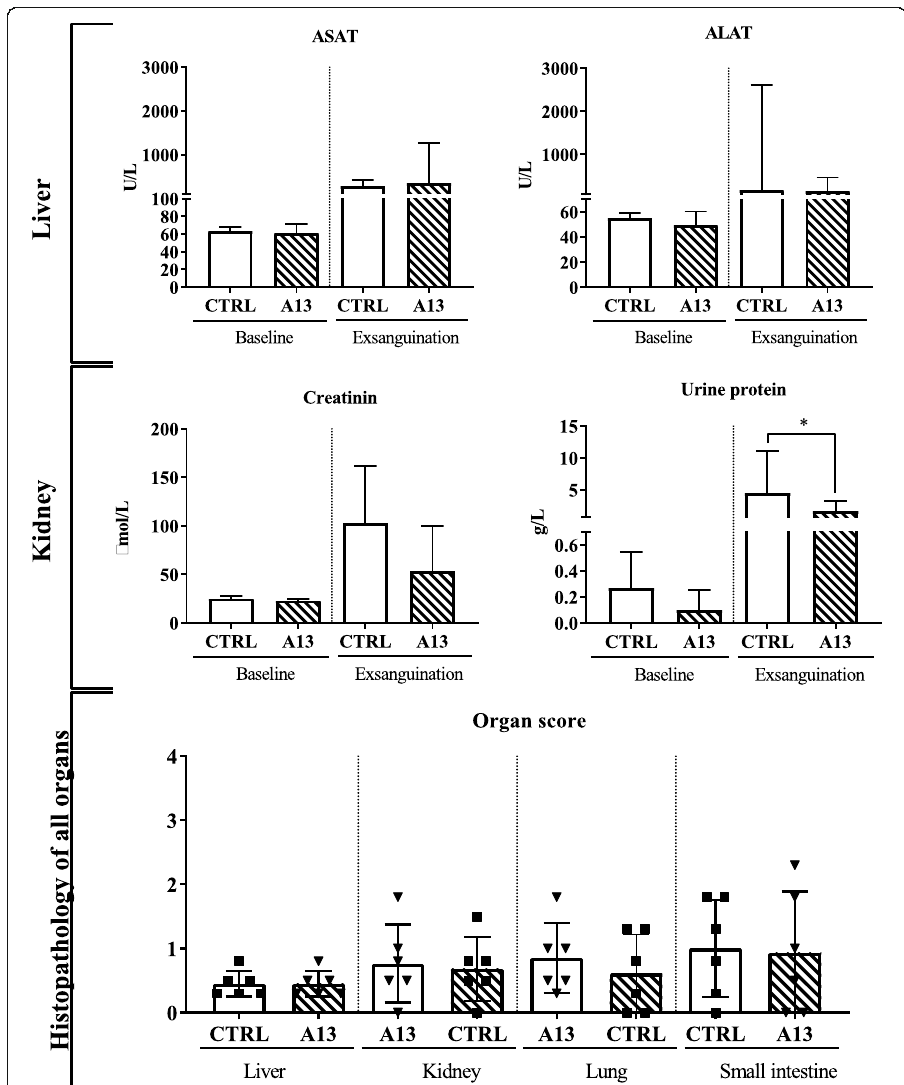
Fig. 3 Biochemical and histopathological examination of organ functioning. Levels of aspartate (ASAT) and alanine transaminase (ALAT), creatinine, and lactate dehydrogenase (LDH) were measured in heparinized plasma collected at baseline and exsanguination. Platelet count was measured in whole blood collected in EDTA tubes. Urine was collected at baseline and exsanguination to measure protein levels. Values presented as median and interquartile range (IQR). * p <